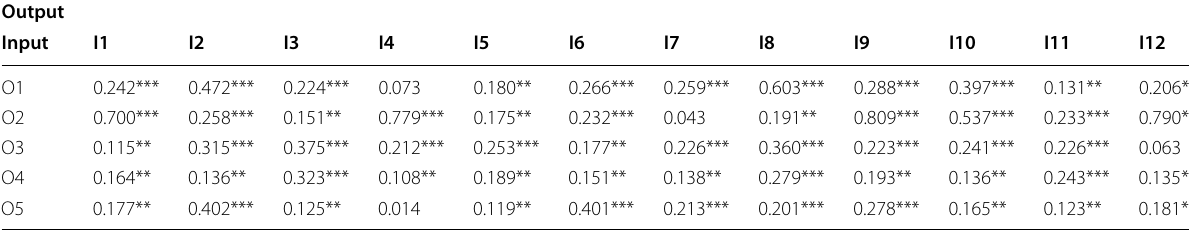
Table 3 Results of the Pearson correlation coefficient analysis for the input and output indicators